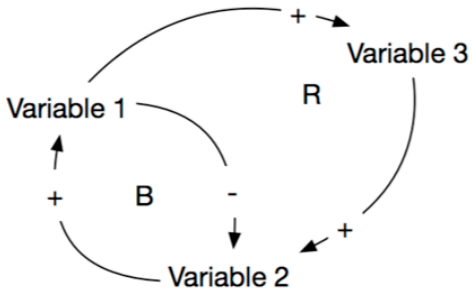
Figure 3. An example of a causal loop diagram with positive and negative relationships between variables, based on (Haraldsson 2000; Sterman 2000).